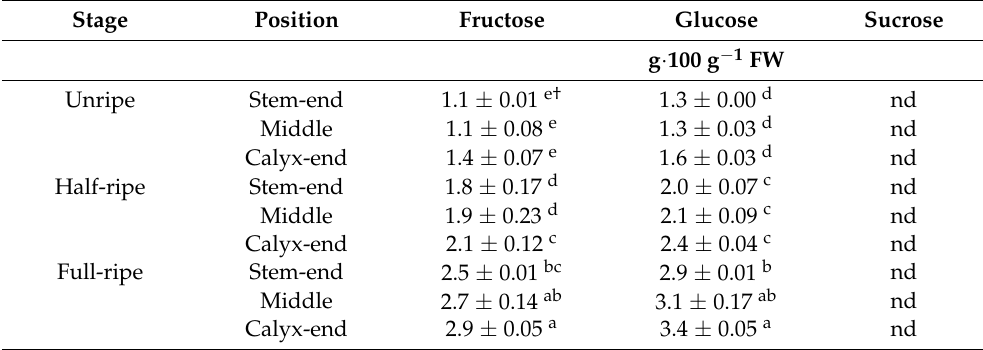
Table 5. Changes in the content of soluble sugars of “Tainung No. 2” Red papaya ( Carica papaya ) pulp at 3 parts across ripening stages: unripe at 16 weeks after anthesis (WAA), half-ripe at 18 WAA, and full-ripe at 20